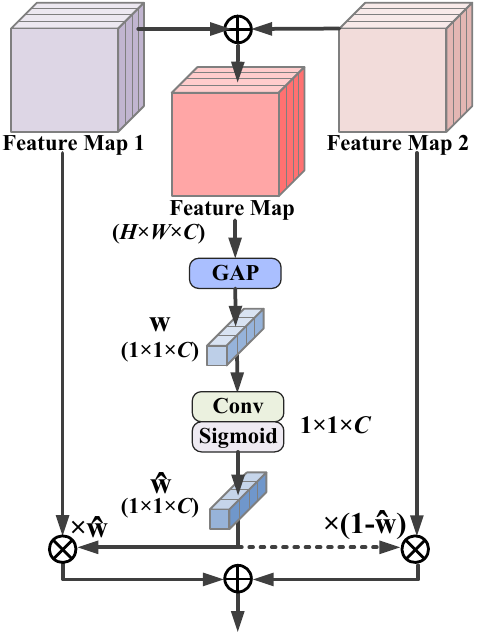
Figure 3. The structure for the feature fusion module